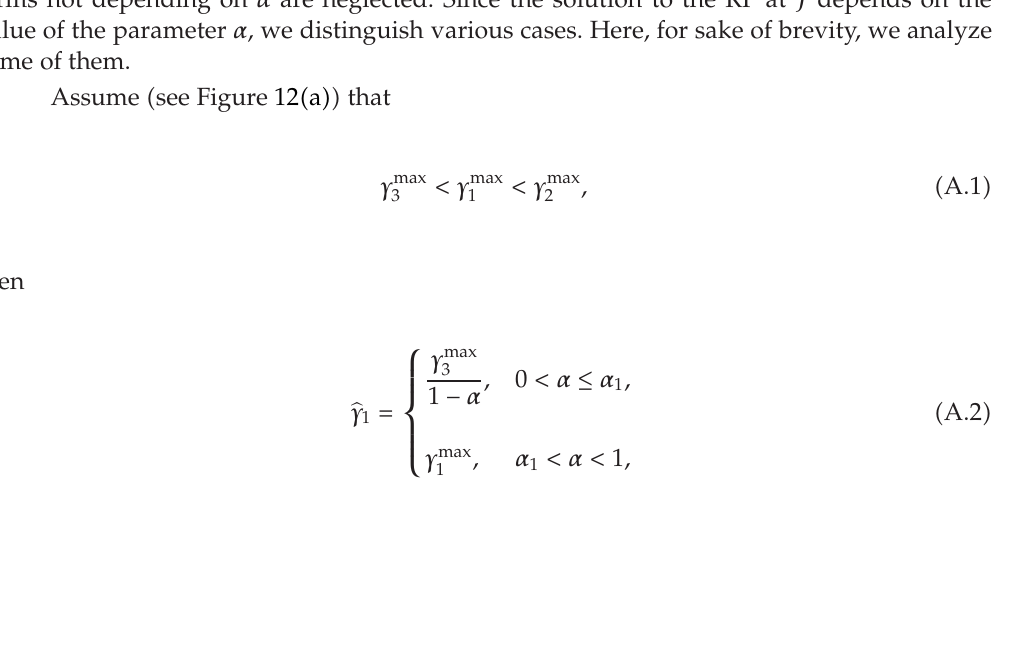
< γ max < γ max 2 3 1